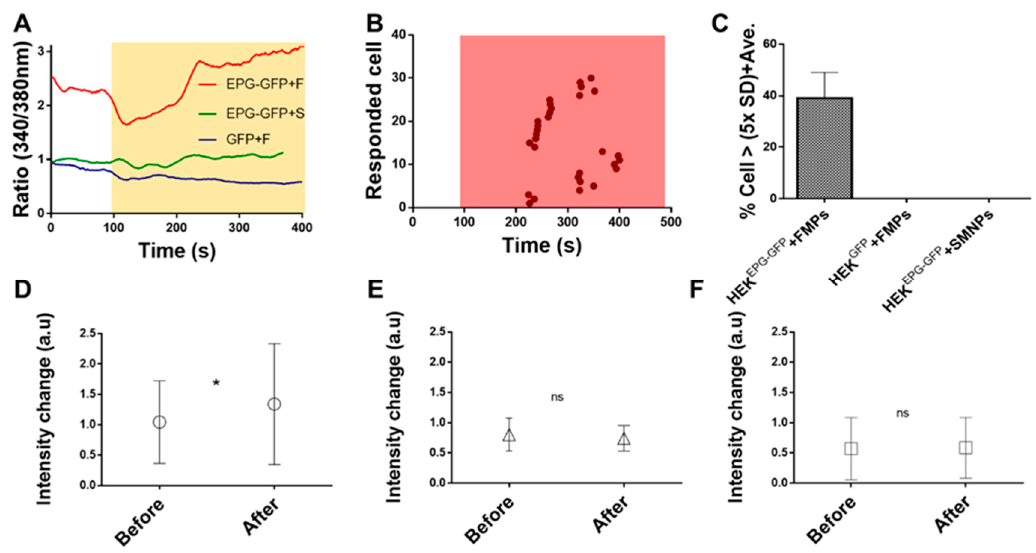
Figure 5. EPG-expressing HEK293T cell response to FMPs. ( A ) Representative [Ca 2 + ] i profiles depending on particle stimulation and gene expression (n = 1). Magnetic particles were added at 100 s, and Fura-2-AM dye was used to analyze [Ca 2 + ] i in EPG-positive cells. ( B ) The number of HEK cells responding to stimulation (n = 30, single cells were evaluated after the addition of magnetic particles). ( C ) A graph of EPG + GFP- and GFP-transfected cells that responded to FMPs and SMNPs. ( D ) Fluorescence intensity change of HEK293T EPG + GFP cells by FMPs (Fura-2-AM-stained HEK293T EPG + GFP cells). ( E ) HEK293T GFP cells with FMPs. ( F ) HEK293T EPG + GFP cells with SMNPs (n = 100). Non-